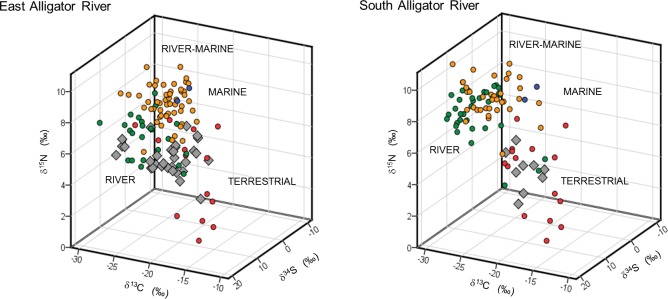
3D plot of the isotopic composition (δ13C, δ15N and δ34S) of crocodiles (diamonds) and potential prey.Samples are from the East and South Alligator Rivers; terrestrial prey includes water buffalo, pigs and wallabies; riverine prey is represented by mullet; riverine-marine prey is represented by barramundi and marine prey is represented by giant sea catfish.